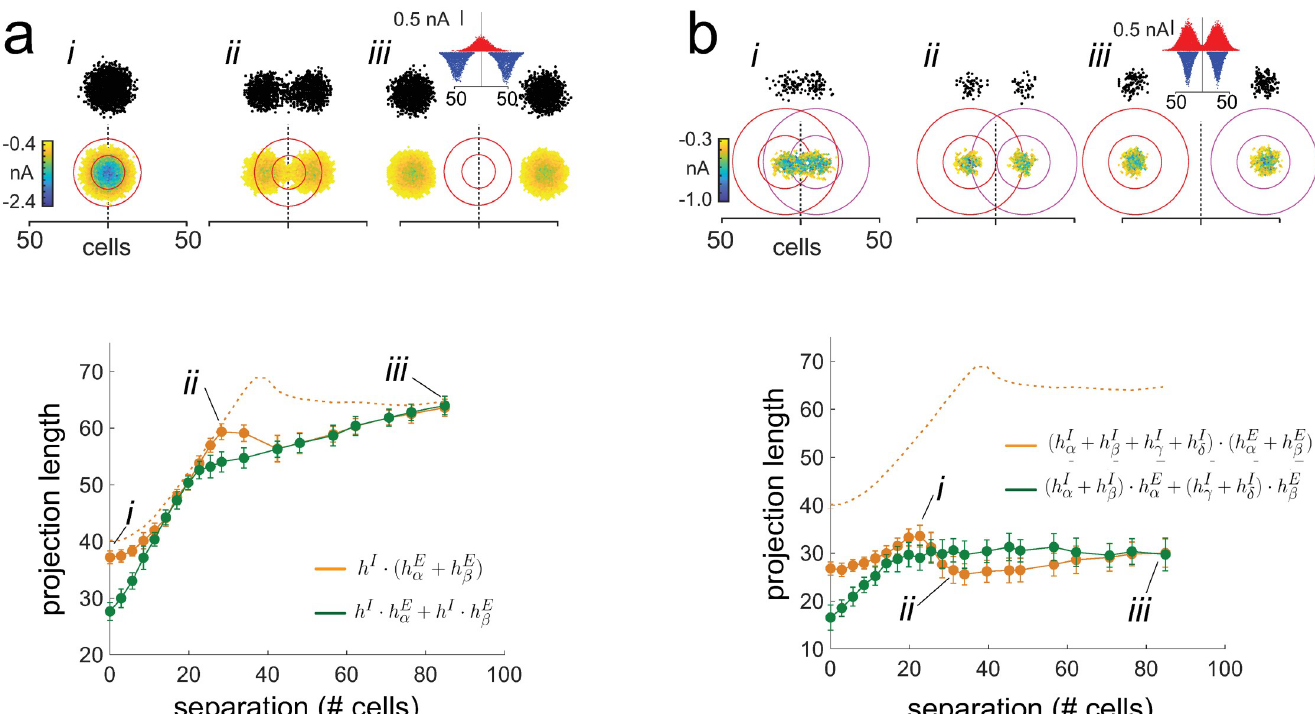
Fig 8. Test of distributive properties. a, top, i-iii Representative activated areas and synaptic fields generated by two excitatory inputs and a single inhibitory input = σ = 10). With the location of inhibition fixed, the two excitatory inputs were separated systematically. The spatial extent of the inhibition is demarcated by the ( σ exc inh red circles (inner circle: 1 σ inh ; outer: 2 σ inh ). Inset in iii shows the excitatory (blue) and inhibitory (red) synaptic current profiles. bottom , plot of synaptic field projection lengths (orange) vs separation of the excitatory inputs. Green symbols are projection lengths obtained with the sequential stimulation protocol (see text). Dotted curve is with no inhibition. b , Simulations with two excitatory-inhibitory pairs, each with center-surround configuration (see inset in iii ). bottom , legend as in a except that the green traces plot the projected lengths obtained when each input ( σ exc = 10, σ inh = 17) was delivered sequentially (see text).